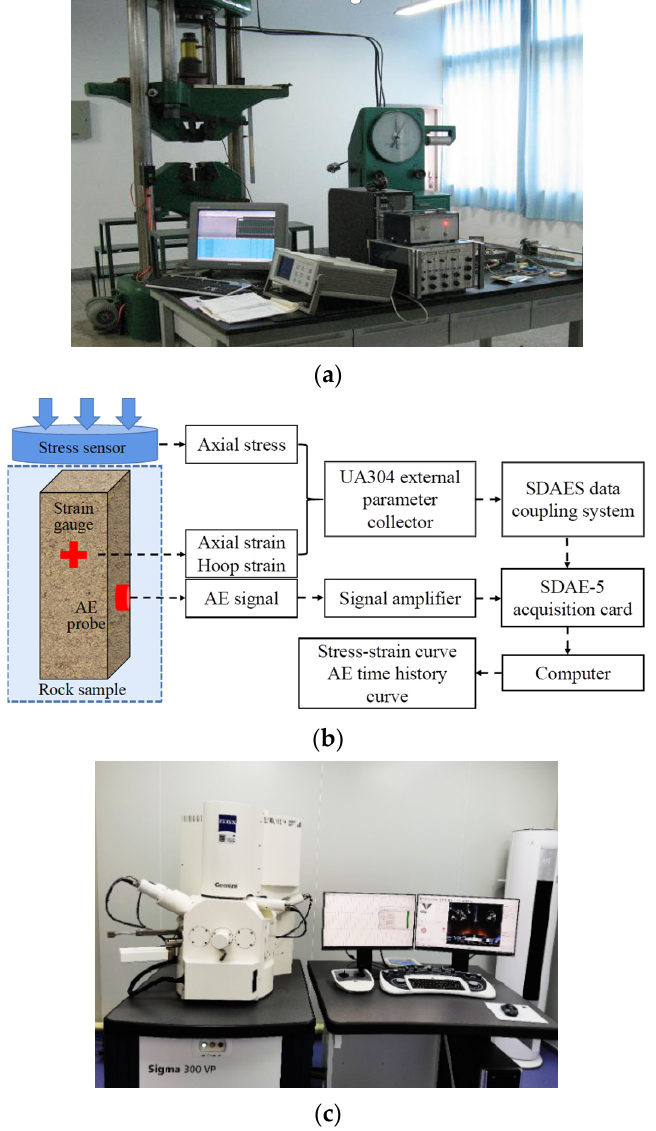
Figure 2. Experimental system: ( a ) Experimental apparatus; ( b ) Stress-strain data coupling system; ( c ) Zeiss ZEISS-SIGMA 300 field emission SEM.